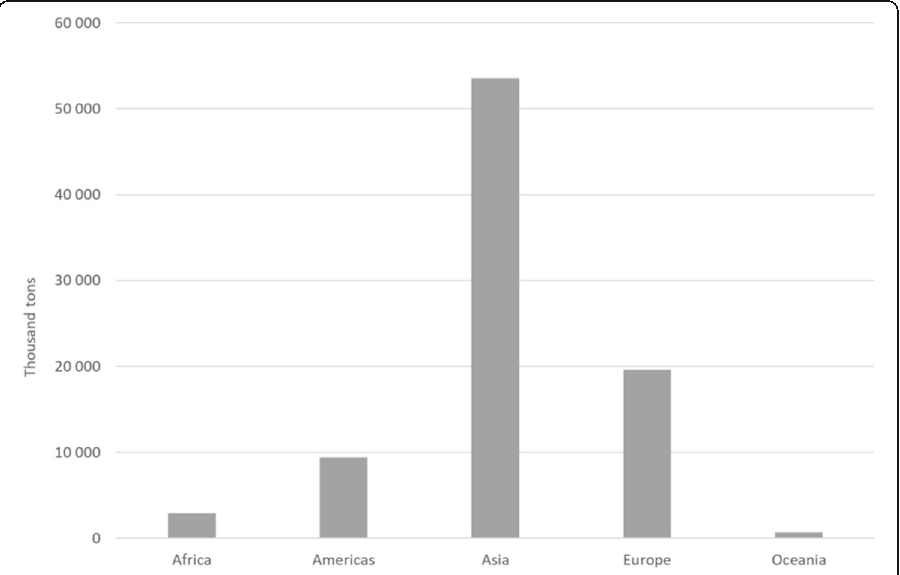
Fig. 2 World apples production by region in